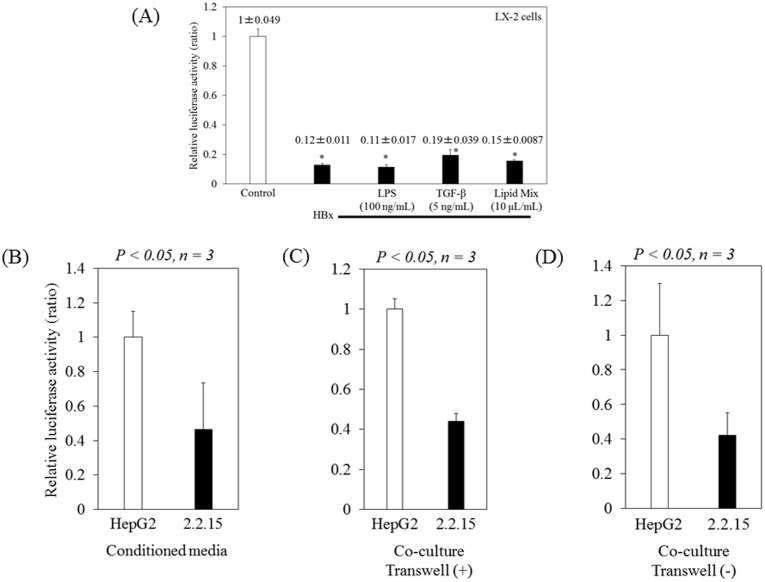
Hepatitis B virus (HBV) inhibits AP-1 activation in LX-2 cells.(A) LX-2 cells were transfected with pAP-1-luc with pCXN2-HBx or pCXN2. After 24 hours of transfection, LX-2 cells were treated with or without 100 ng/mL LPS (Novus Biologicals, Littleton, CO, USA), 0.1% lipid mixture 1 (Sigma), or 5 ng/mL TGF-β (Wako Pure Chemical, Osaka, Japan). (B) After 24 hours of transfection with pAP-1-luc, the cells were treated with conditioned media from HepG2 or from HepG2.2.15 (indicated as 2.2.15). (C), (D) After 24 hours of transfection with pAP-1-luc, the cells were co-cultured with HepG2 or HepG2.2.15 with (C) or without the transwell system (D). After 48 hours of transfection, AP-1 activity was measured by luciferase assay. Data are expressed as mean ± standard deviations of triplicate determinations. *P < 0.01 (vs. control).